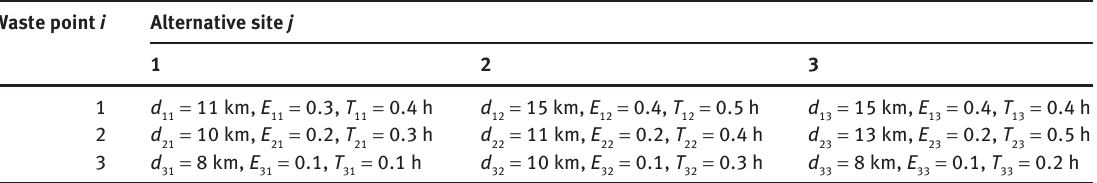
Table 1. Relevant Data of Alternative Sites and Waste